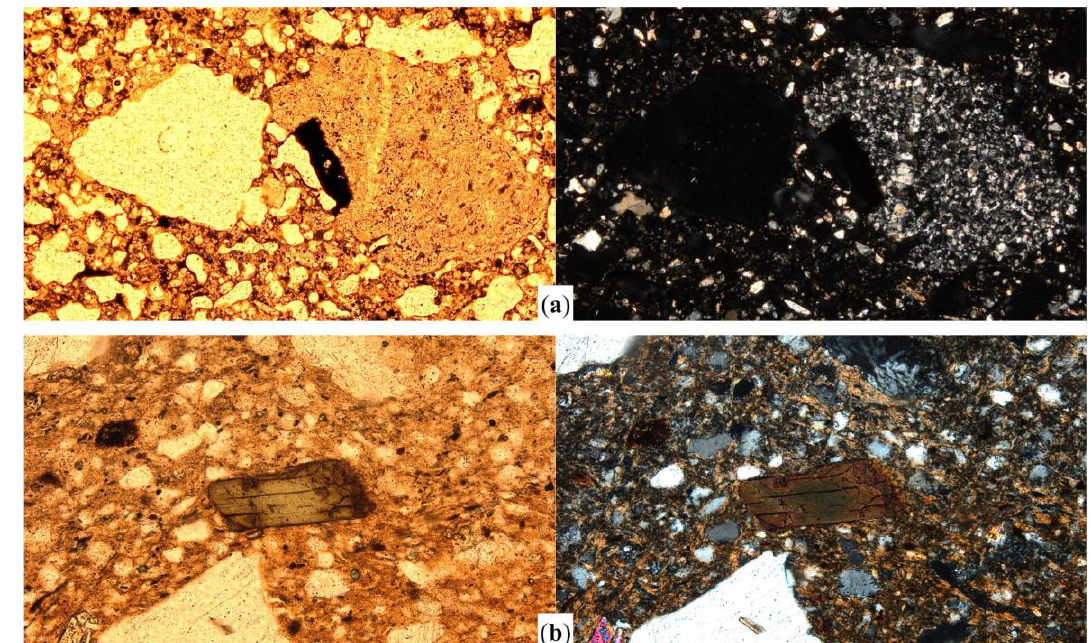
Figure 7. Photomicrographs of high temperature sample CAU26 ( a ), showing vitrified matrix and a biotite inclusion; and hornblende inclusion in sample SAO18 ( b ) with colour and optical properties slightly altered by heat. All the images were captured in plane polarized light (left column) and crossed polars (right column). Sample CAU26 (a) is pictured at 40× magnification. Image width = 3 mm. Sample SAO18 (b) is pictured at 100× magnification. Image width = 1 mm.